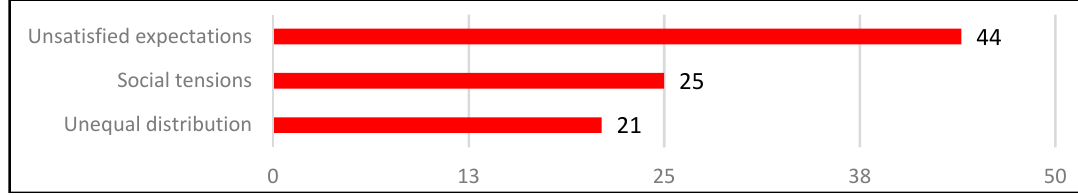
Figure 7. References to ES-unrelated social costs in the Chingaza case study (own representation).